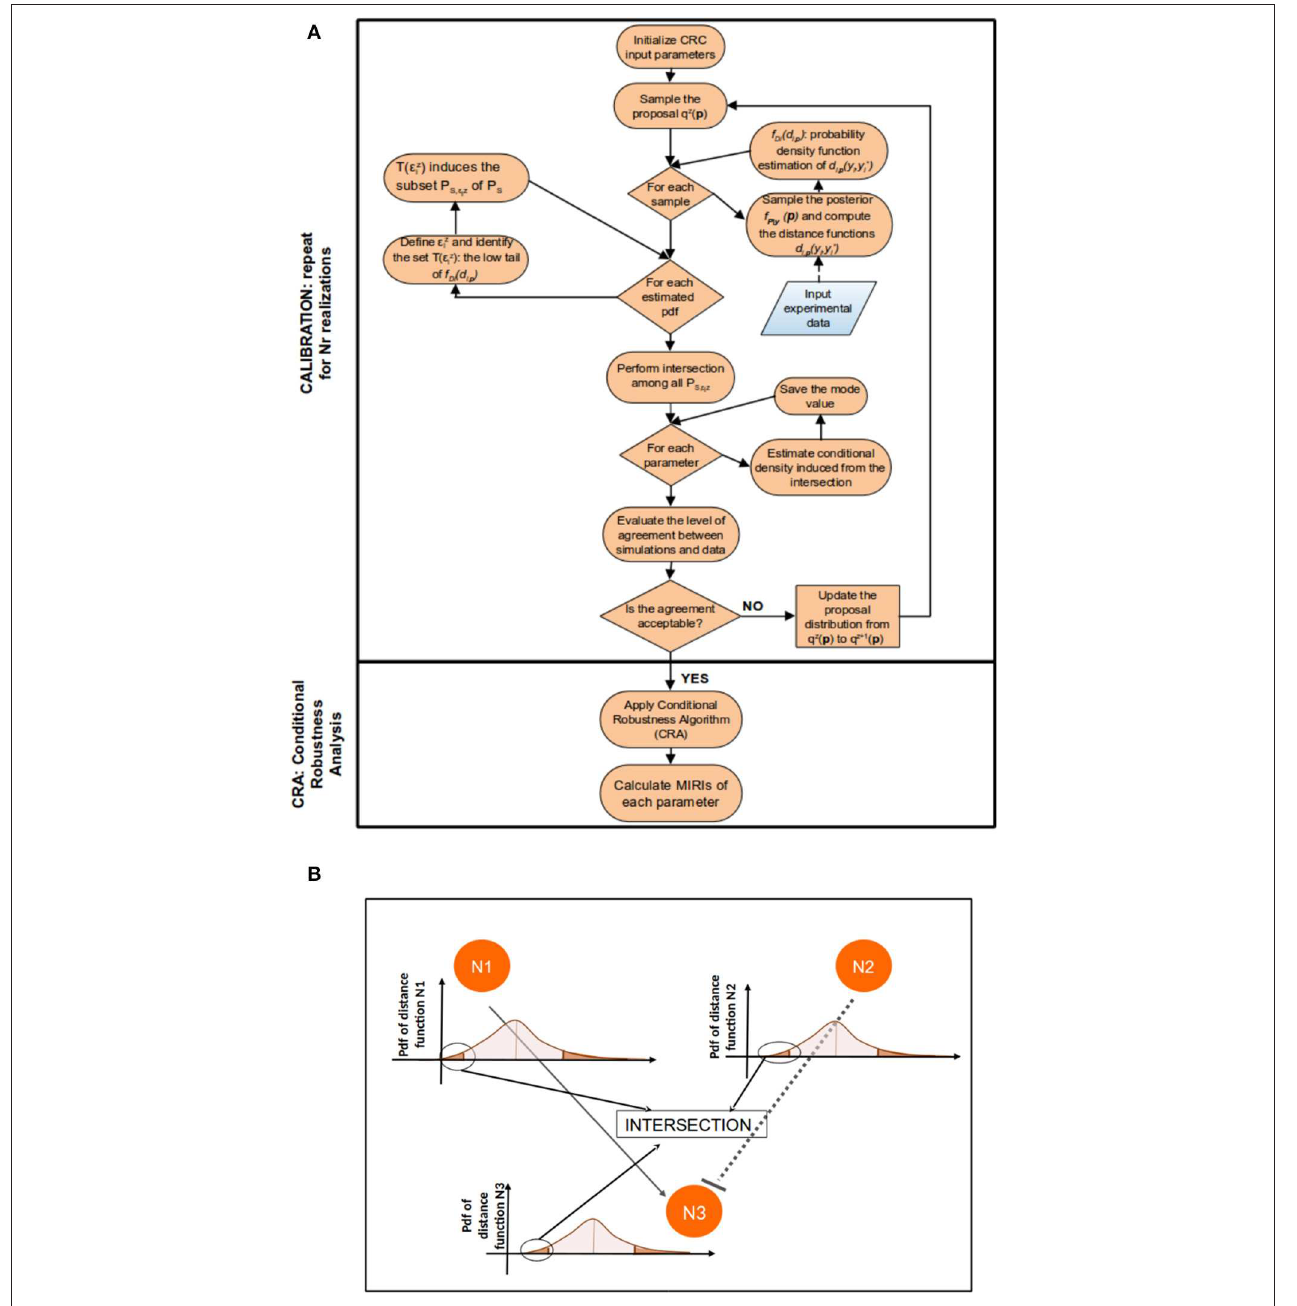
FIGURE 1 | CRC algorithm. (A) The flowchart of CRC is divided in two main phases: model calibration and robustness analysis. (B) Detail of steps 3–5 of CRC. N1, N2, and N3 represent three model observables that interact among each other. For each observable, a distance function d i , p is computed and the corresponding pdf f D ( d i , p ) is estimated. We are interested only in the low tail of each pdf, since it is the region where the model observables are closer to the experimental data. Then, all i the low tails are intersected among each other to identify P S , ǫ z .